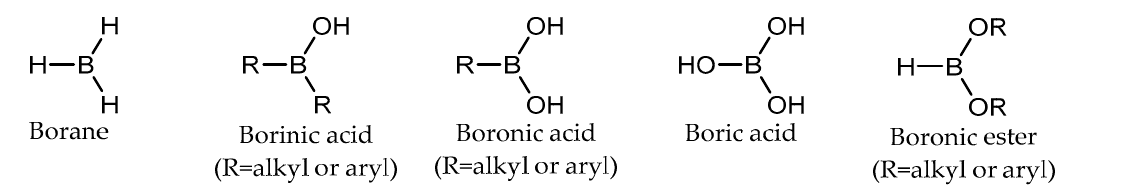
Figure 1. Organoboron compounds.